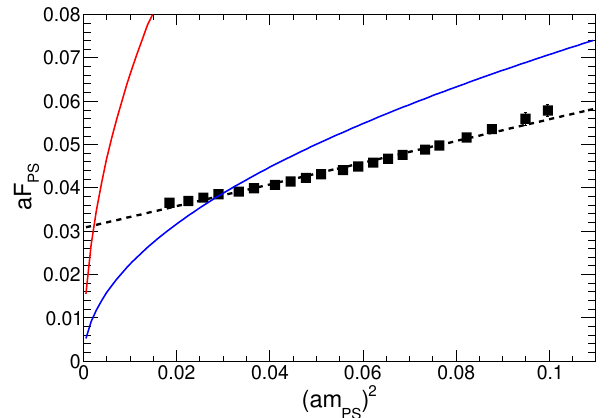
Figure 17 . The decay constant aF PS versus the square of the mass ( am PS ) 2 . The black symbols and dotted line are the numerical results and (cid:12)tting results of the normal con(cid:12)guration, respectively. The solid red and blue curves indicate equations (6.2) and (6.3),